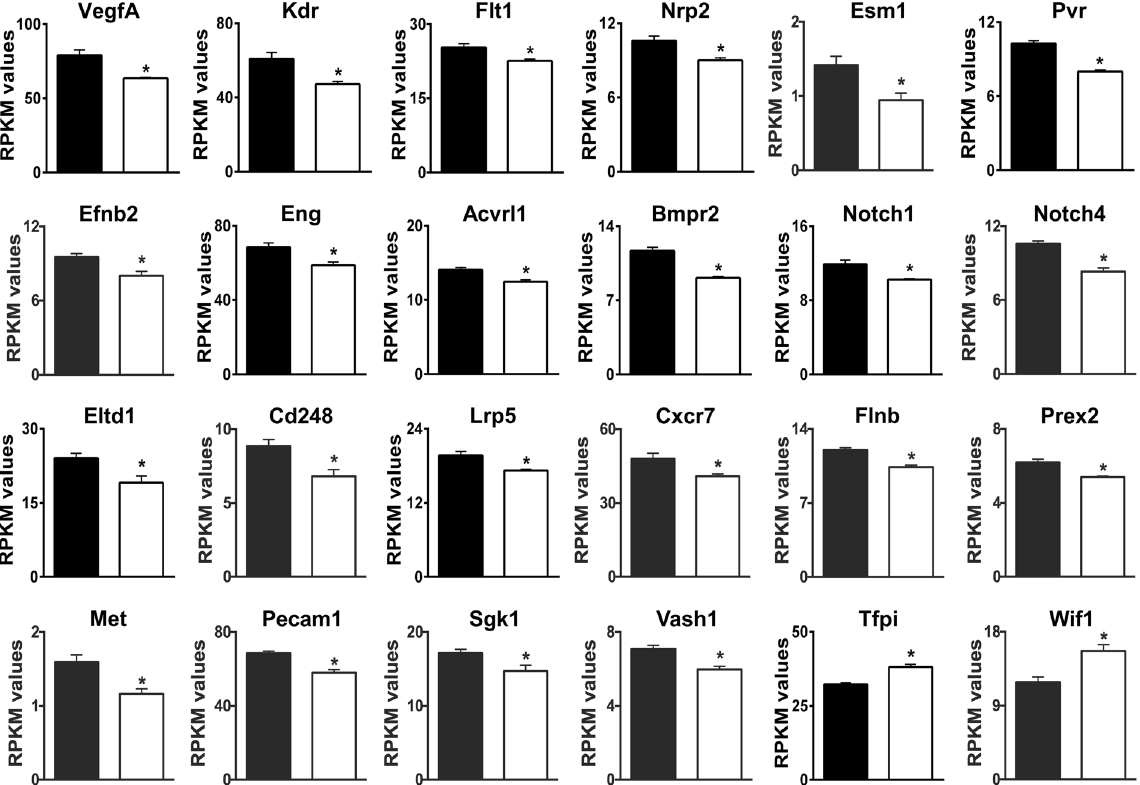
Figure 2. Differential expression of genes involved in angiogenesis. Relevant genes were identified by Gene Ontology analyses and/or by PubMatrix analyses of genes with an FDR < 0.05. RPKM values for WT (black bars) and AE3-null (white bars) hearts are shown. The genes shown are a subset of 143 genes in Supplementary Table S2; values are means ± SE; n = 4 for each genotype; * p ≤ 0.01 vs WT